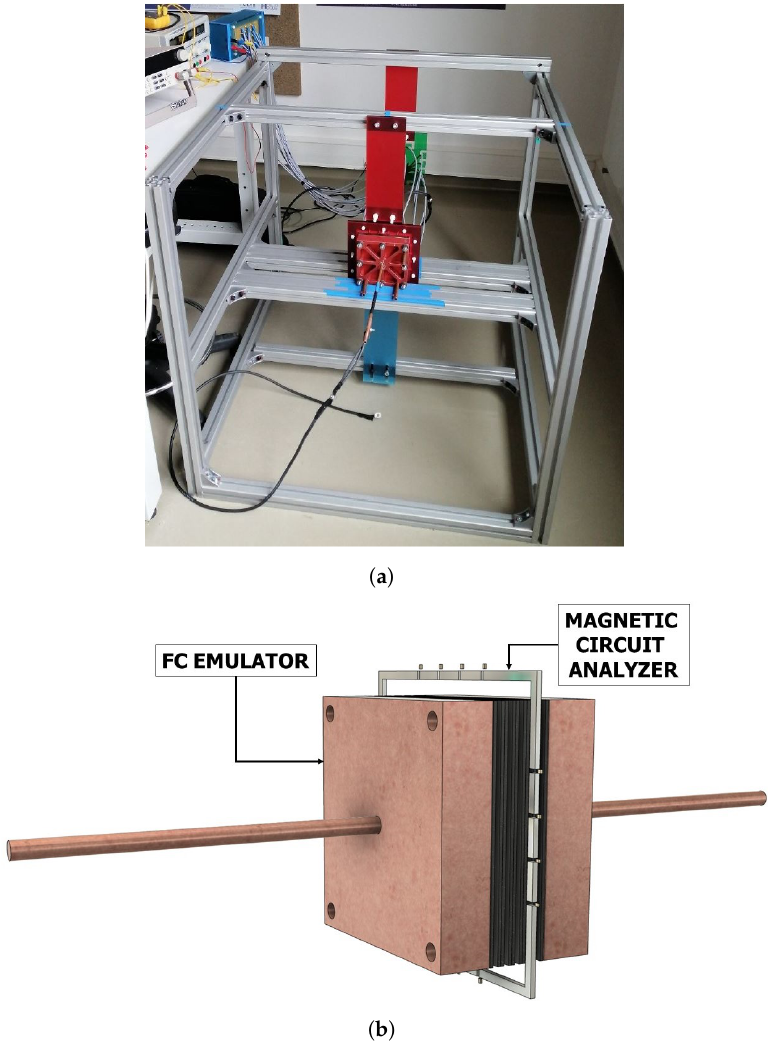
Figure 7. Passivized FC (a) test bench, (b) stack and magnetic analyzer circuit. In this experiment, the conduction fault covering 25% of the third cell active area is realized by three polyethylene insulator foil positioned to the left of the GDL of the third cell of the stack. These insulators have been inserted at the front, middle and back of the two GDLs to ensure that the current will not flow through this faulty area, see Figure (8a).